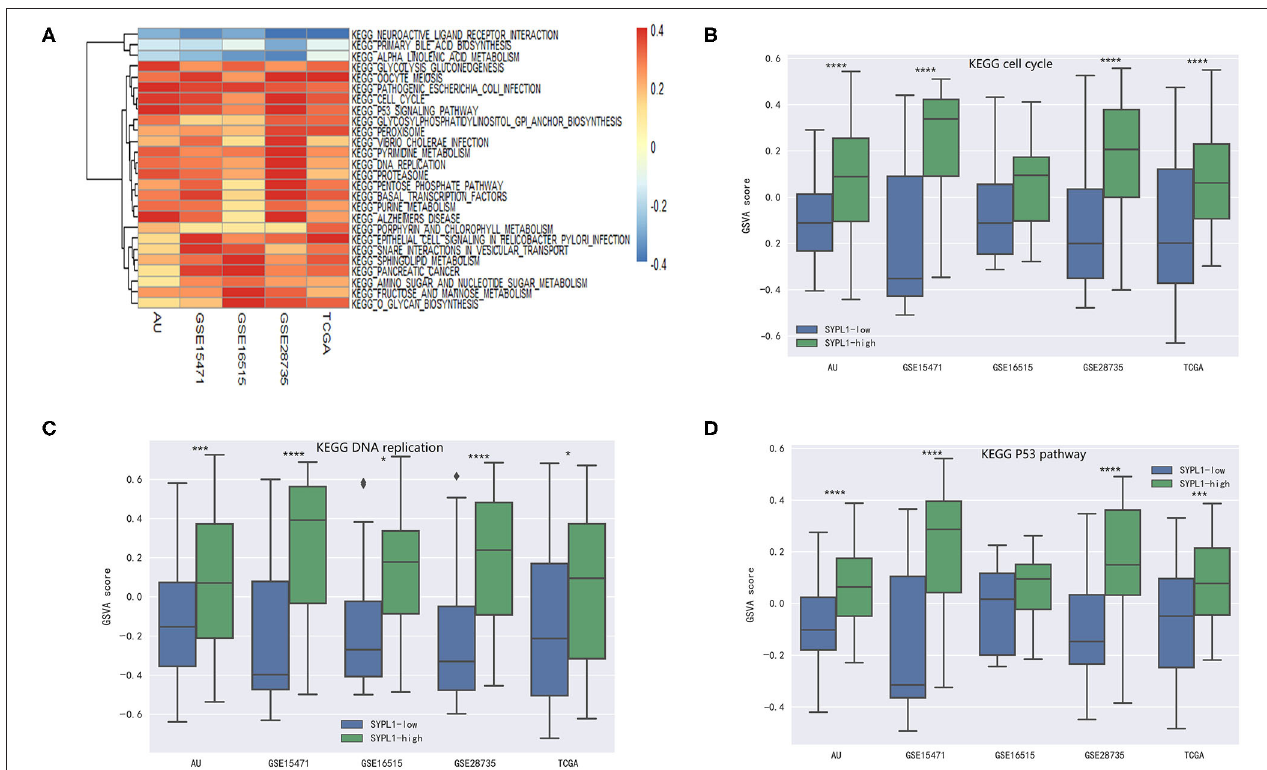
FIGURE 3 | SYPL1 was related to cell proliferation and apoptosis. (A) Correlation coefficients ( r ) between SYPL1 and GSVA scores of KEGG pathways were calculated. Twenty-six pathways with r > 0.1 in GSE15471, GSE16515, GSE28735, TCGA, and PACA-AU or pathways with r < − 0.1 in these datasets were identified as pathways related to SYPL1. (B) The GSVA score of the KEGG cell cycle gene set in SYPL1-high and SYPL1-low samples. (C) The GSVA score of the KEGG DNA replication gene set in SYPL1-high and SYPL1-low samples. (D) The GSVA score of the KEGG P53 pathway gene set in SYPL1-high and SYPL1-low samples (Both tumor tissues and adjacent tumor tissues of GSE15471, GSE16515, and GSE28735 were taken into analysis in (B–D) , while TCGA and PACA-AU included only tumor tissues). * p < 0.05, ** p < 0.01, *** p < 0.001, and **** p < 0.0001.